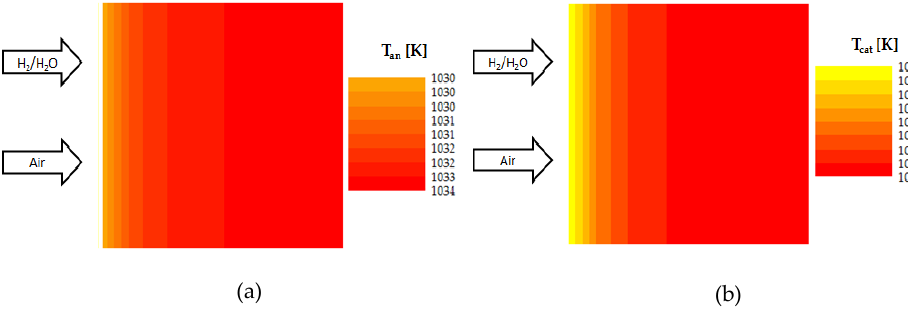
air: ( a ) H 2 , ( b ) H 2 O, ( c ) O 2 molar fraction [-], ( d ) current density [A/cm 2 ] in Pt-mesh+LSCF cell.